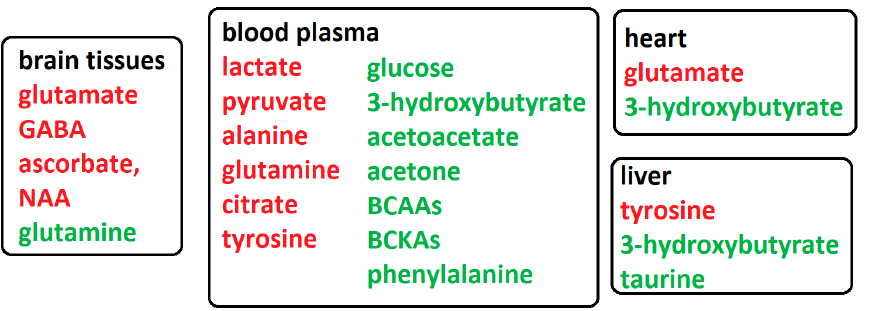
Figure 1. Schematic representation of the main metabolomic changes after cerebral ischemia in rodent models in brain tissues, blood plasma, and remote organs, as detected by 1 H NMR (12,29,33,34,37); red—decreased levels; green—increased levels.